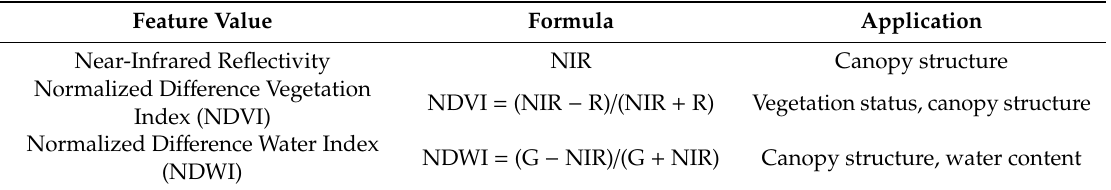
Table 3. Feature value selection. R, G and NIR are the reflectance of red, green and near-infrared bands,